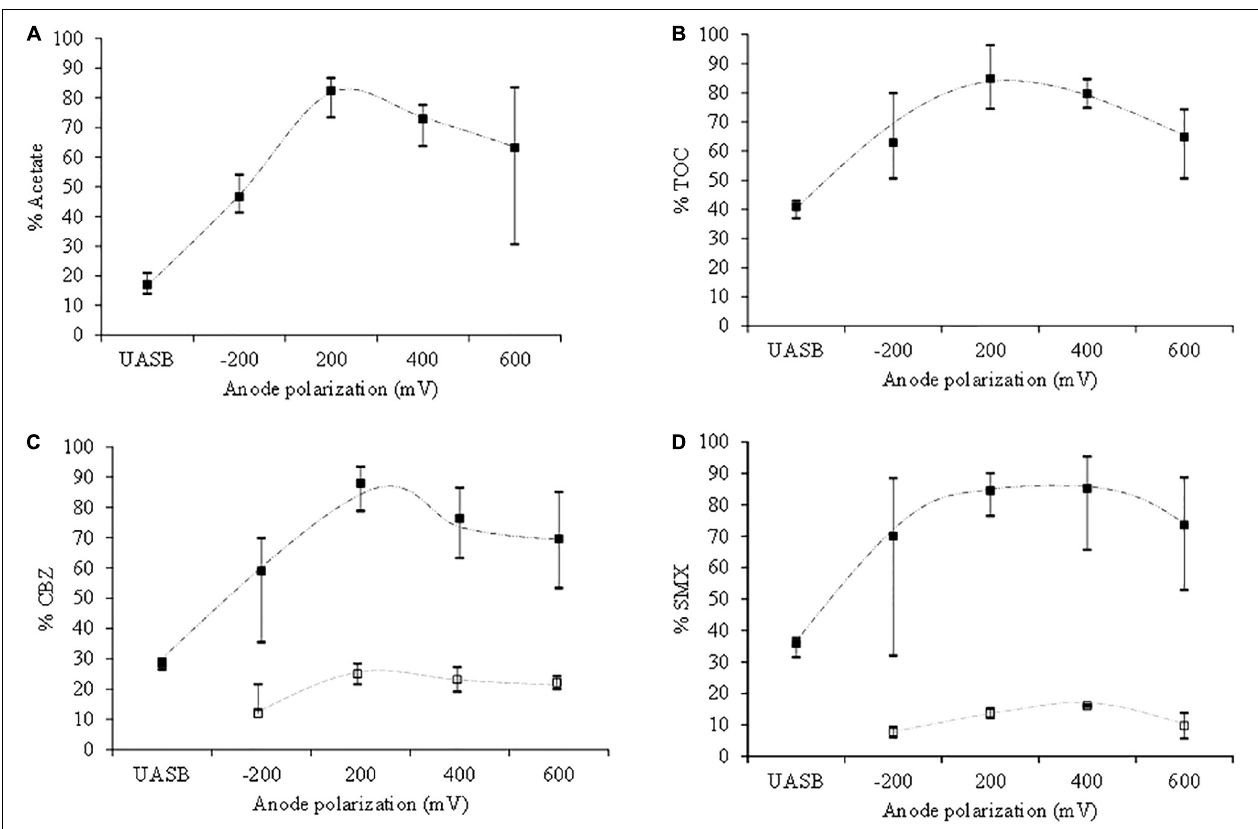
FIGURE 2 | Acetate, TOC, CBZ, and SMX removal in the UASB reactor (no anode potentials) and ME-FBR in a vast range of applied anode potentials ( − 200, 200, 400, and 600 mV). (A) Acetate removal. (B) TOC removal. (C) CBZ removal. (D) SMX removal. Symbols: (cid:4) % removal, (cid:3) % CBZ and SMX removal in electrochemical control